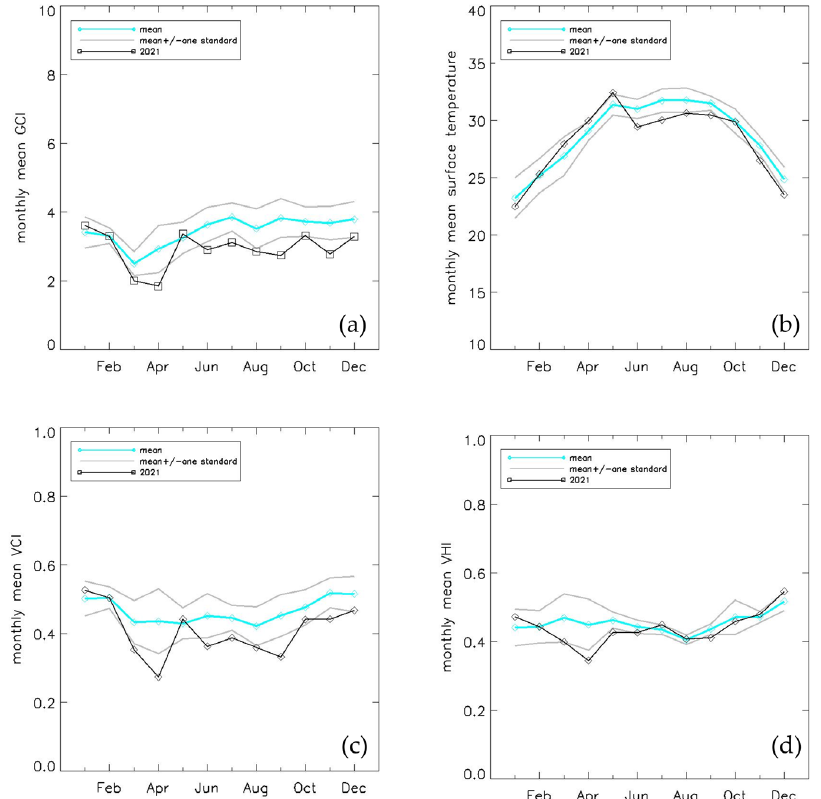
Figure 6. The time series of monthly mean indices and variables stepping through the 12-month annual cycle (January to December, as marked on the abscissa). For each index, the blue line and the accompanying pair of gray lines are the mean and +/ − one standard deviation derived from the data for 2016–2021. The black line is the value of the index for 2021. ( a ) CI green ; ( b ) surface temperature; ( c ) VCI; (d) VHI.